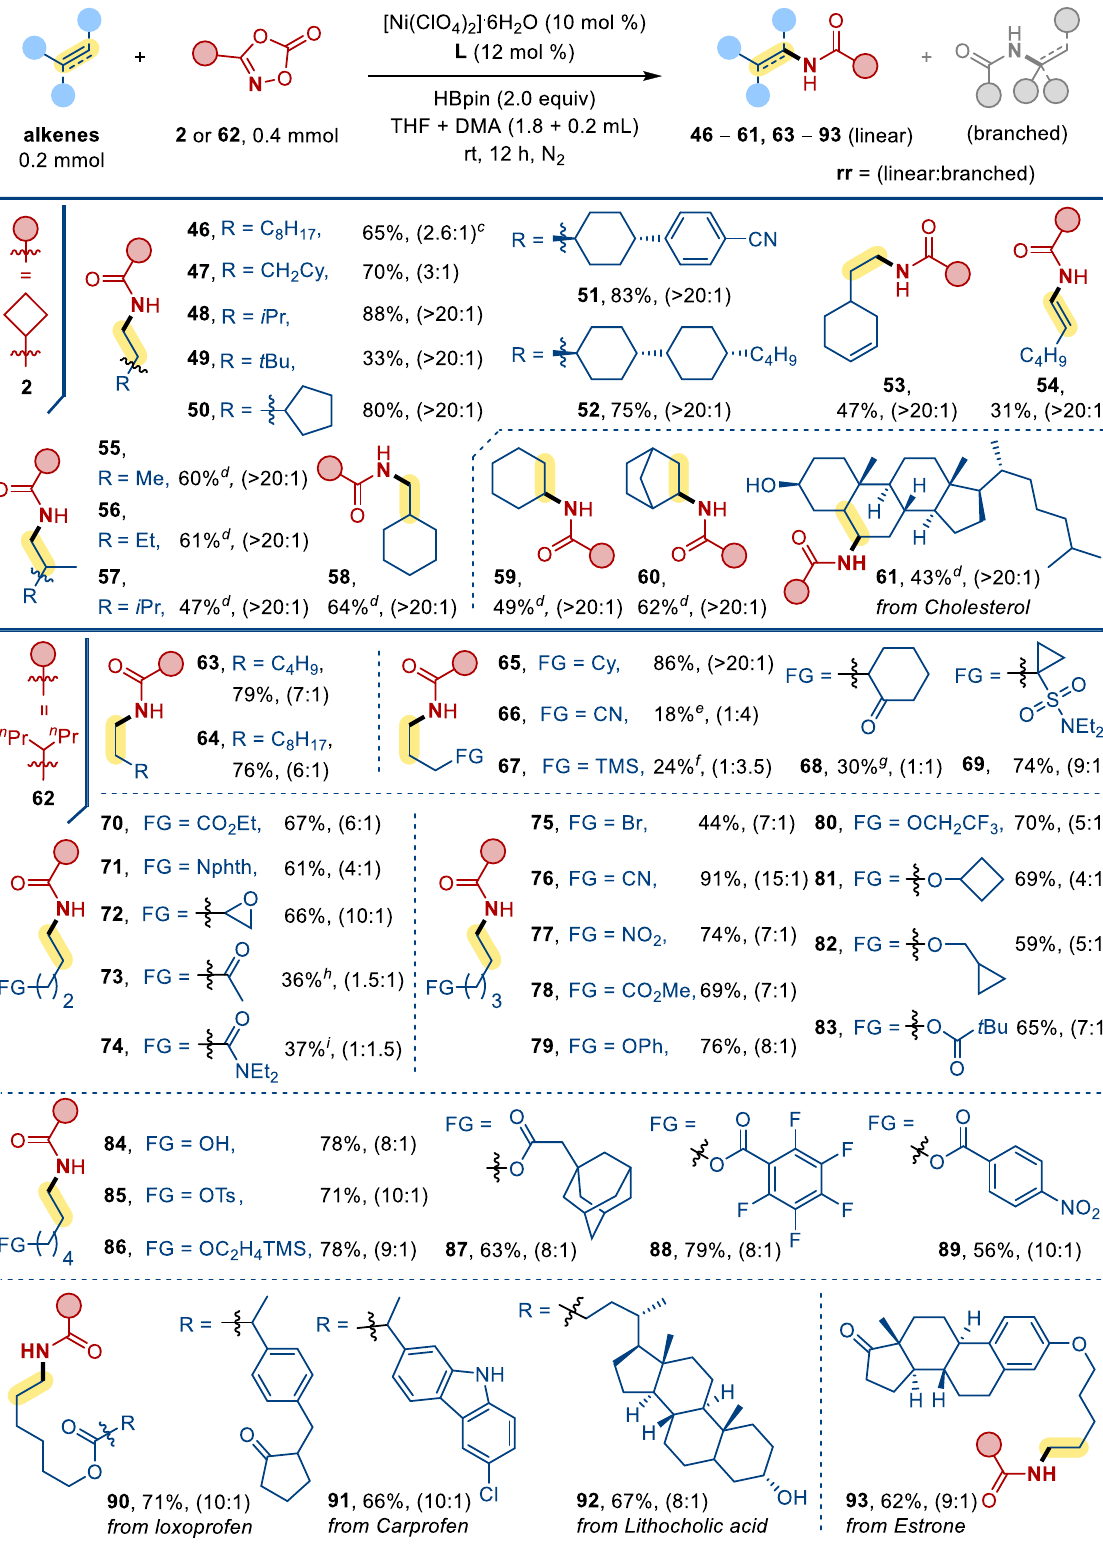
Fig. 3 Scope of alkenes. a Reaction conditions: alkenes (0.2 mmol), 2 / 62 (0.4 mmol), [Ni(ClO 4 ) 2 ] ∙ 6H 2 O (10 mol %), L4 (12 mol %), HBpin (2.0 equiv), THF + DMA (1.8 + 0.2 ml), in N 2 at room temperature for 12 h unless otherwise speci fi ed. b Isolated yield. c Regioisomeric ratio ( rr ) is de fi ned as linear/ branched. d L3 instead of L4 . e 73% branched product. f 70% branched product. g 50% branched products. h 53% branched products. i 51% branched